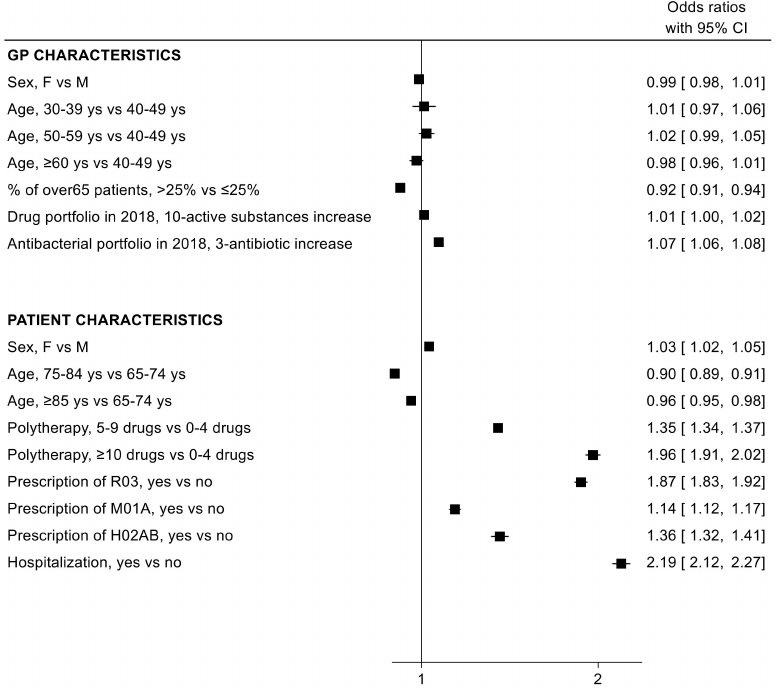
Figure 2. Odds ratio (OR) and 95% confidence intervals (95% CI) for the association between patient/general practitioner (GP) characteristics and the probability of being exposed to at least one antibiotic (J01) prescription.